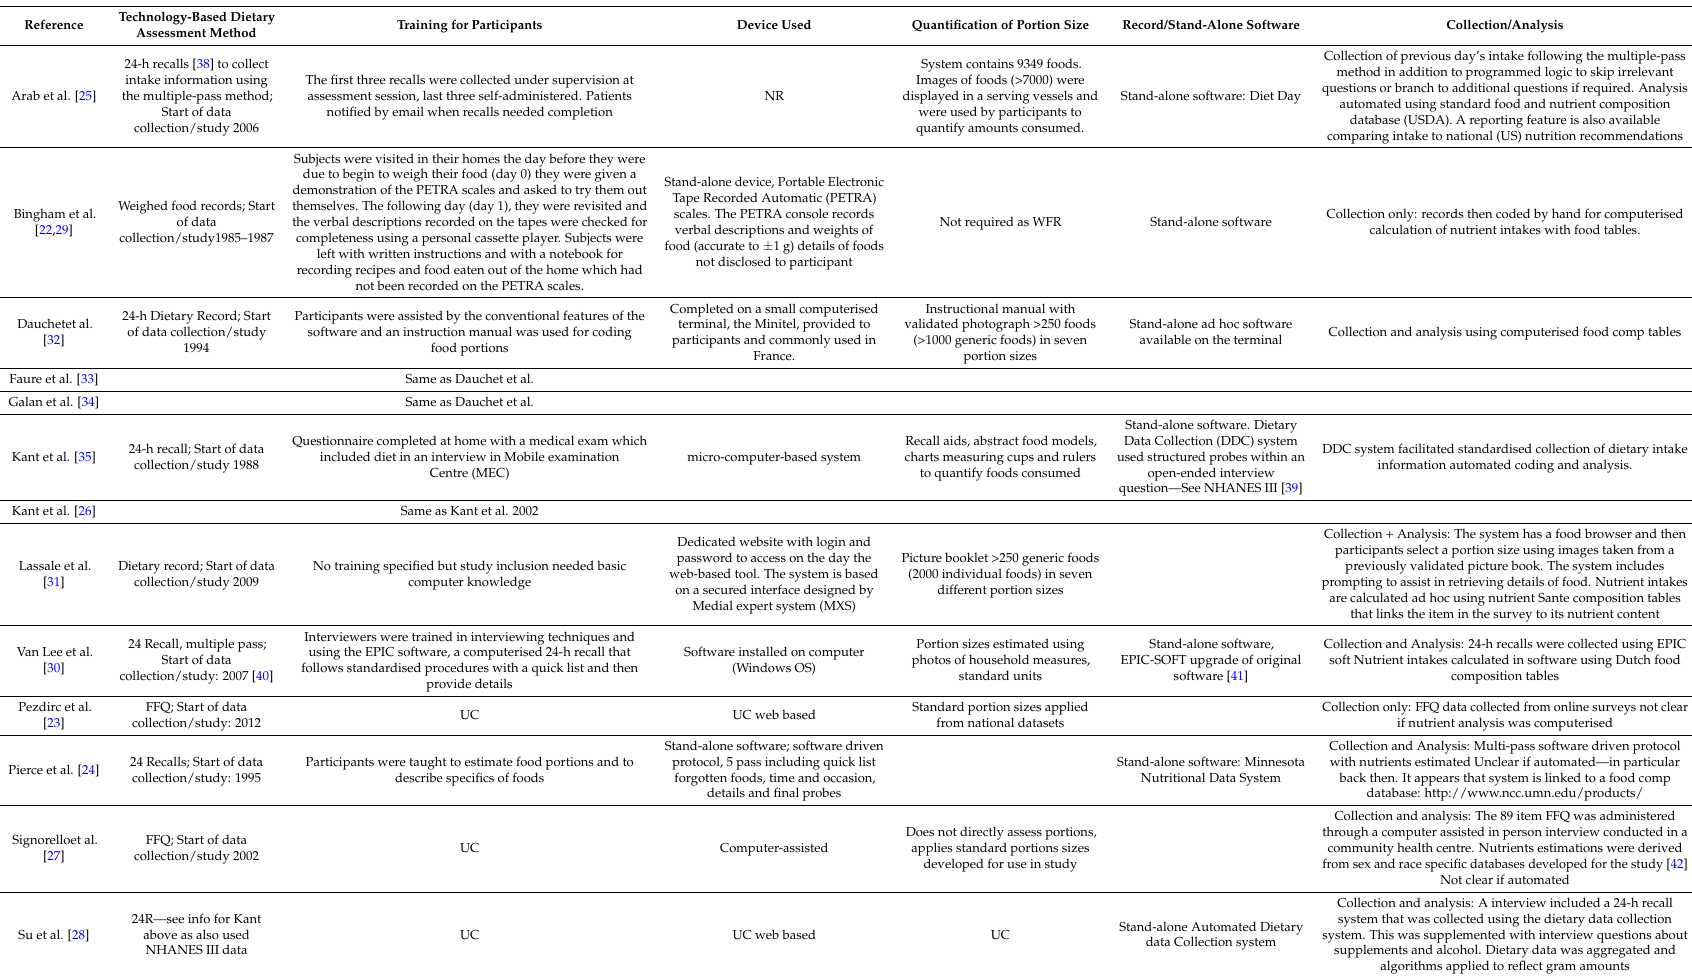
Table 2. Description of technology components of dietary measures from the included